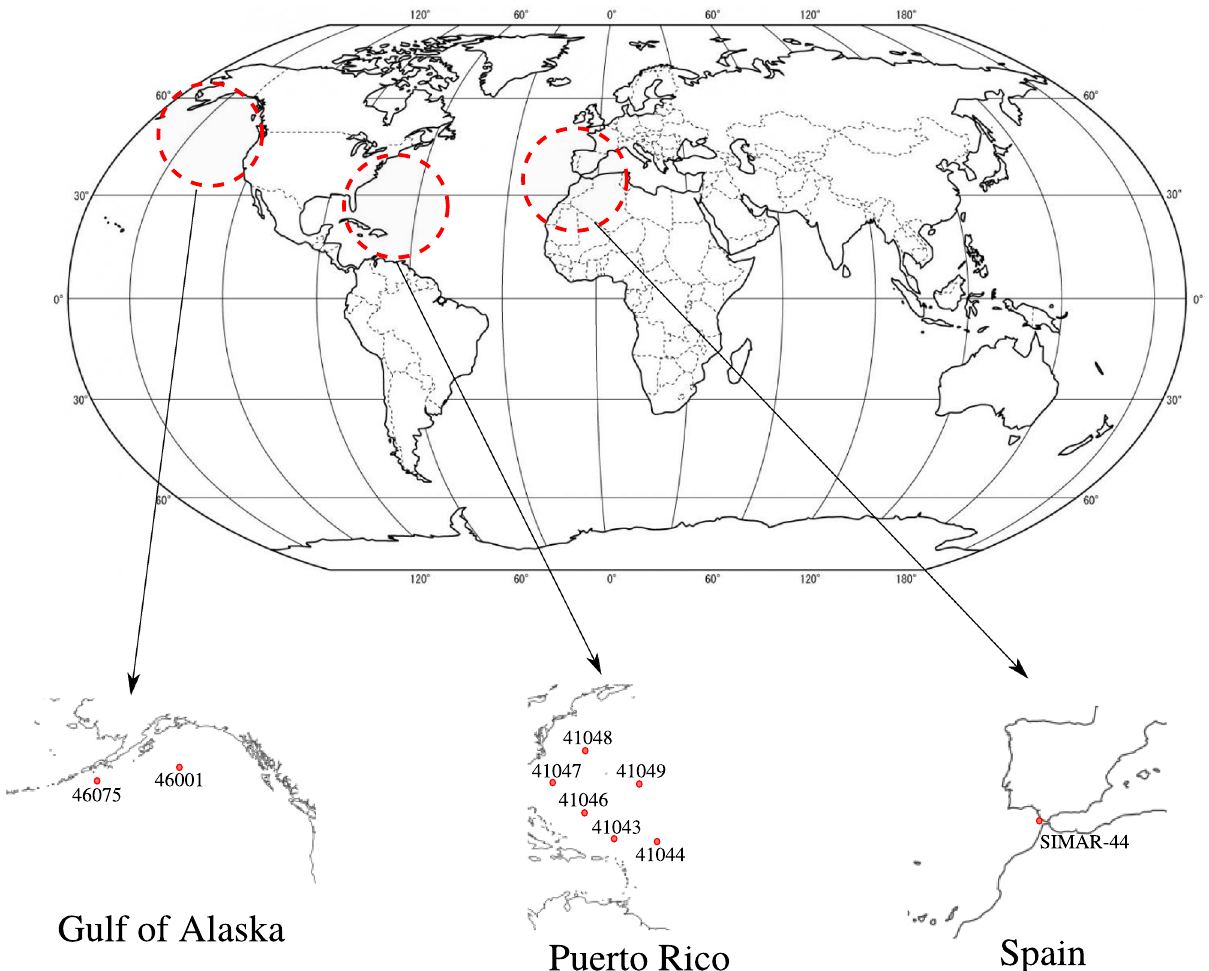
Figure 1. Locations of the different buoys considered for the